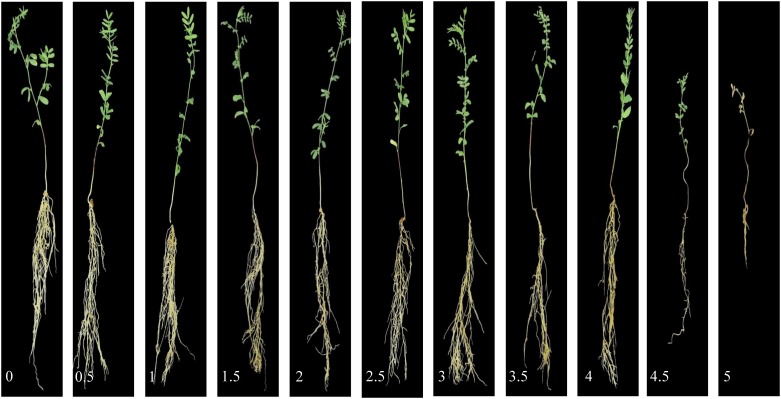
Aphanomyces root rot disease severity scale. Images were processed with background removed for better visualization.